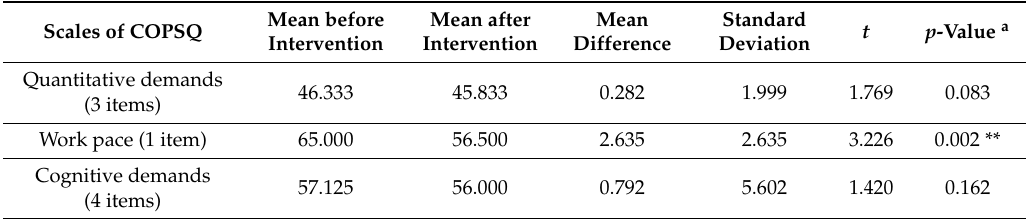
Table 4. Means and standard deviations of scores of different scales of Thai version of the psychosocial questionnaire in the case before and after the intervention ( n =